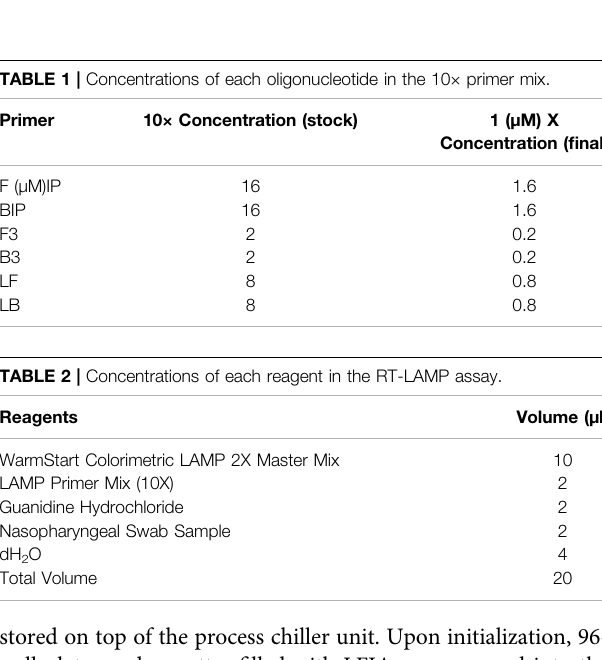
FIGURE 1 | The work fl ow of our RT-LAMP-LFIA prototype system and the schematic of our automatic system. (A) Work fl ow schematic from initial patient sample placementtoend.Samplesundergoacolorimetricloop-mediatedisothermalampli fi cationreaction.Samplesthatarepositive(asindicatedbyacolorimetricchangefrom red toyellow) are transferred toamultiplexed lateral fl ow assay test strip, which can differentiate from up tothree targetsequences. (B) Machine schematic (C) Example 96-well plate image captured by the overview camera before RT-LAMP reaction. The red circle represents the region of interest (ROI) of each well. The decision matrix is determined by the color change within the red circles (D) Example 96-well plate image captured by the overview camera after RT-LAMP reaction. (E) Final decisionmatrixforRT-LAMPreactionreadout (F) ExamplerenderingofLFIAcassetteimagecapturedbytheoverviewcamerabeforeLFIA.Dashedrectanglesrepresent ROIs of the LFIA cassettes. (G) Example rendering of LFIA cassette image captured by the overview camera after LFIA.